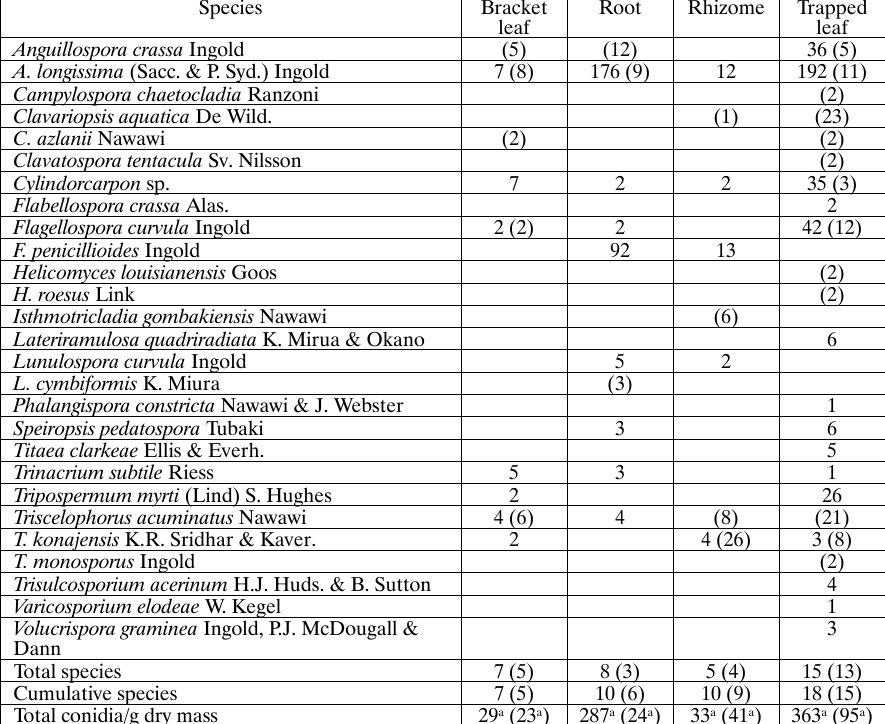
Water-borne hyphomycetes (conidia/g dry mass) recovered from tissues of Drynaria and trapped leaf litter in riparian trees of Sampaje region during summer and monsoon (in pa- renthesis) (mean, n = 5) (same letters across the total conidia of each substrate between summer and monsoon indicate no significant difference; P > 0.05; paired t -test)